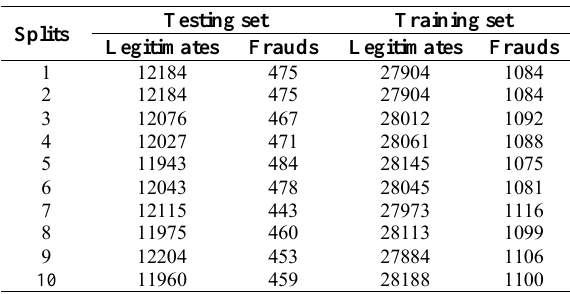
Table 2. Number of fraud and legitimates in each